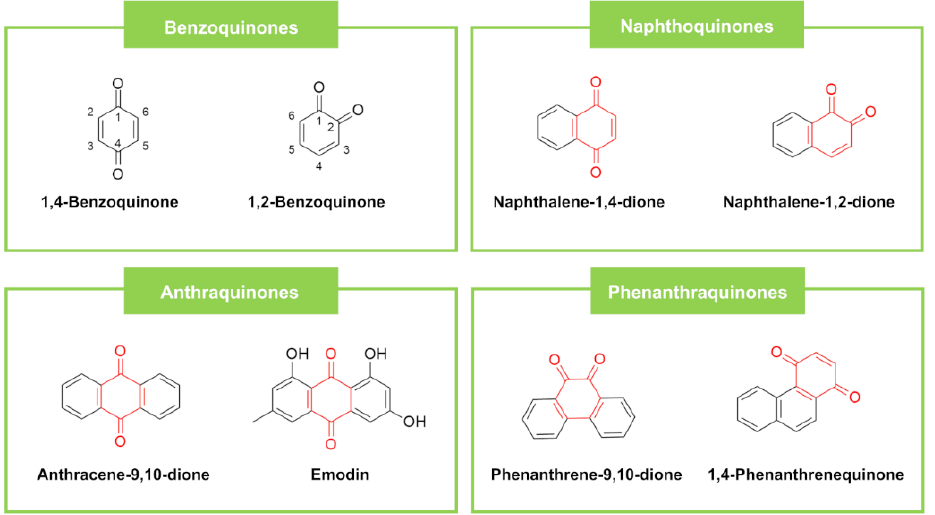
Figure 7. Representative chemical structures of different classes of quinones.